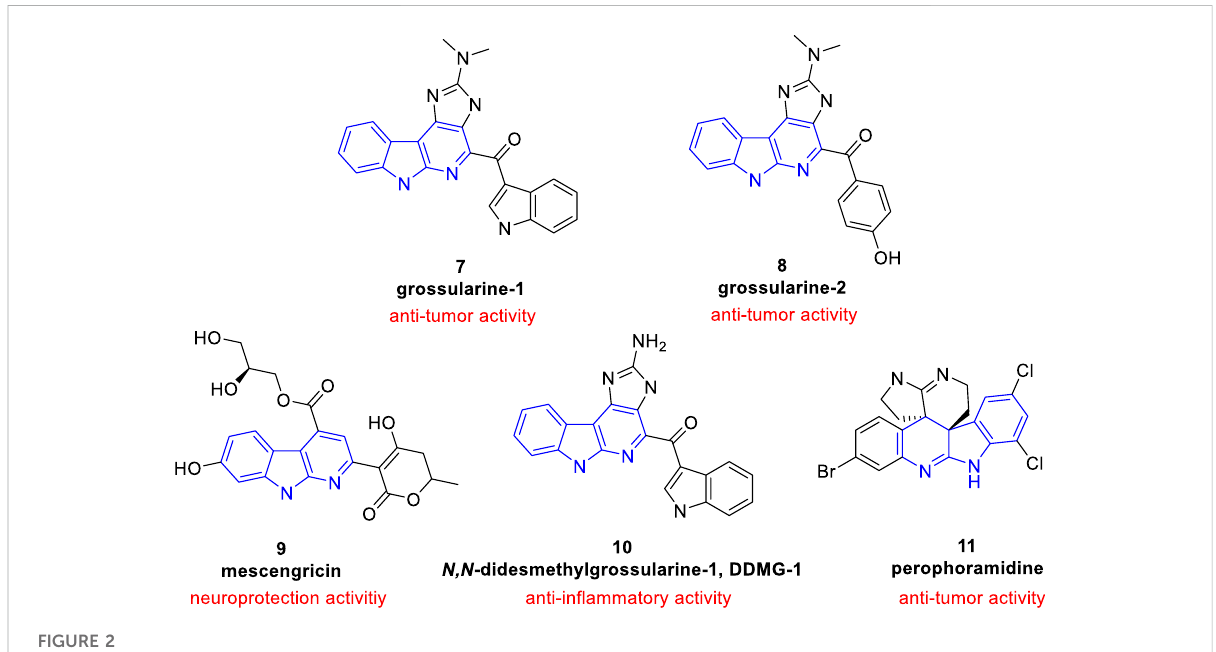
FIGURE 2 Structures and biological activities of α -carboline based natural